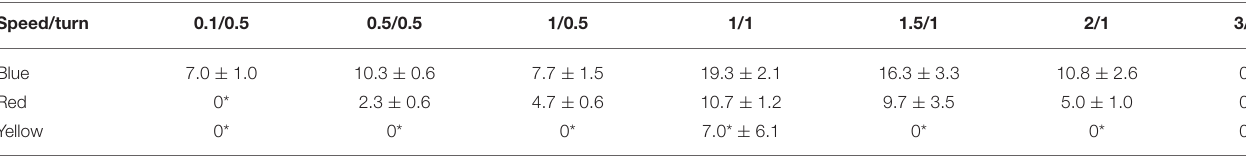
TABLE 1 | Collision avoidance at different speeds: distance to the obstacle when crossing the obstacle-line (mean over 3 trials ± standard deviation in [cm]) at different speed- and turn-factors and for different colors of the obstacle. Speed/turn 0.1/0.5 0.5/0.5 1/0.5 1/1 1.5/1 2/1 3/1 Blue 7.0 ± 1.0 10.3 ± 0.6 7.7 ± 1.5 19.3 ± 2.1 16.3 ± 3.3 10.8 ± 2.6 0* Red 0* 2.3 ± 0.6 4.7 ± 0.6 10.7 ± 1.2 9.7 ± 3.5 5.0 ± 1.0 0* Yellow 0* 0* 0* 7.0* ± 6.1 0* 0*